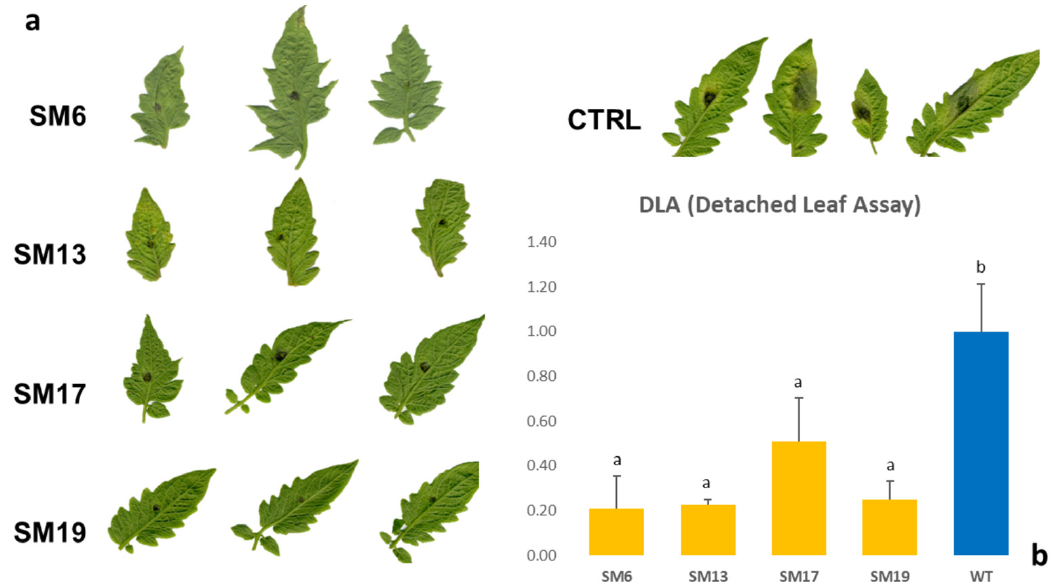
Figure 2. ( a ) Detached leaves assay with Phytophthora infestans performed on four pmr4 San Marzano mutants (SM6, 13, 17, and 19) and a wild type plant as a control group at eight days post-inoculation (dpi). ( b ) In the histogram, normalized LAD% values are reported for each genotype. The y-axis shows the mean ratio of the score of the mutant/control group; bars represent standard deviation (sd). Statistical differences among mutant/control were analyzed with a two-tailed t -test ( p < 0.05). Multiple comparisons were performed using two-tailed Student’s t -test with post-hoc Bonferroni’s correction.